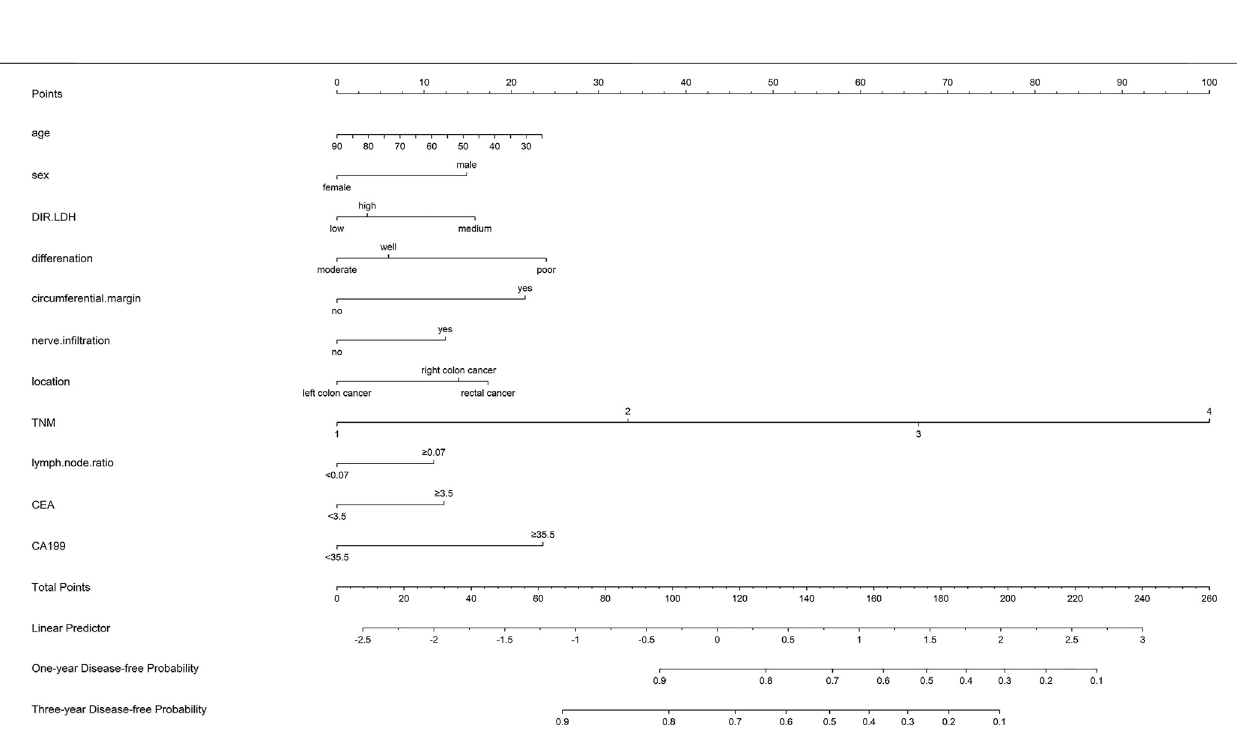
Frontiers in Molecular Biosciences |